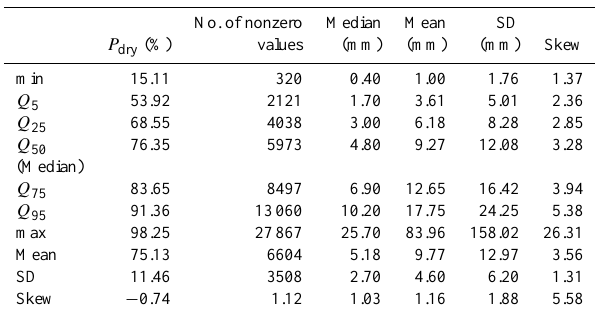
Table 1. Some basic statistics of the 15137 records of daily rain- fall. Apart from probability dry ( P dry ) , these statistics are for the nonzero daily